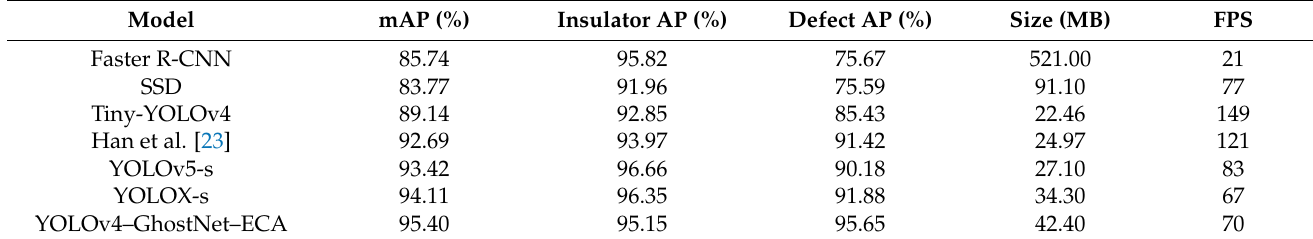
Table 3. Comparison of different models.